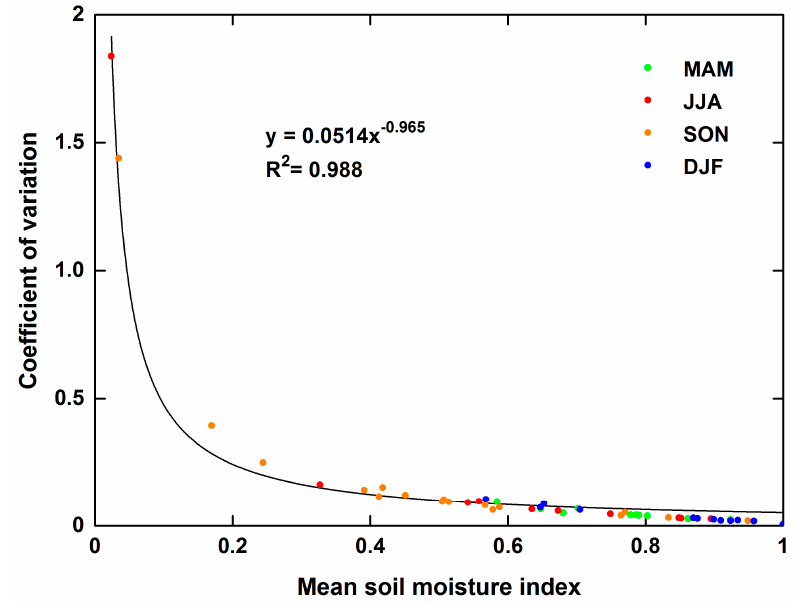
Figure 6. Relationship between mean soil moisture index and the coefficient of variation (CV). Each point denotes an acquisition and the colors represent different seasons (Spring: MAM; Summer: JJA; Autumn: SON; Winter: DJF).